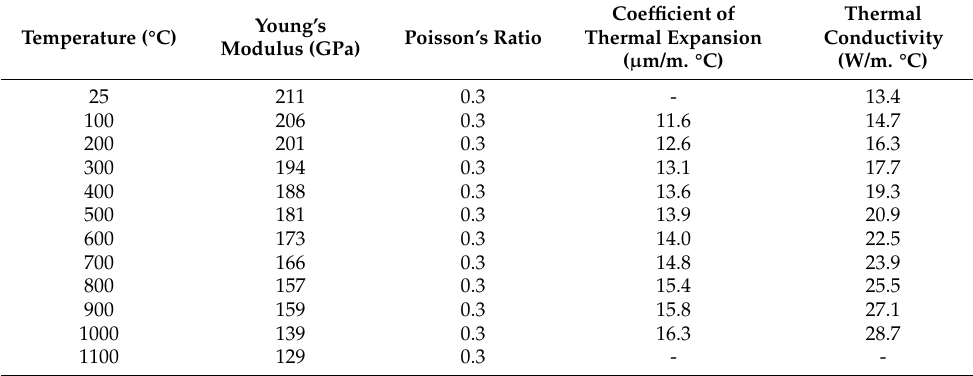
Table 3. Properties of Inconel 617 alloy.